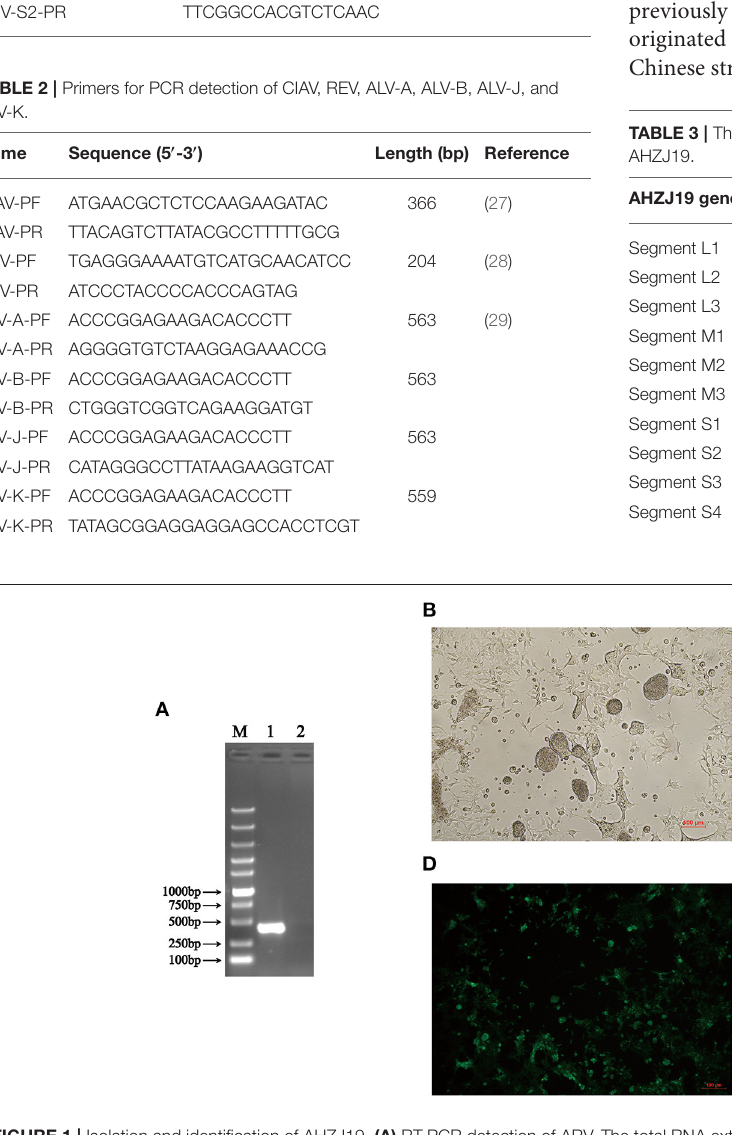
FIGURE 1 | Isolation and identification of AHZJ19. (A) RT-PCR detection of ARV. The total RNA extracted from the liver tissue samples was tested by RT-PCR using primers specific to ARV. Lane M was Super DNA Marker; Lane 1 was the liver tissue of chickens from that farm; Lane 2 was negative control. (B,C) The CPE in LMH cells at 24 hpi after inoculation with supernatants of the RT-PCR-positive liver tissue sample. (B) The supernatants of the RT-PCR-positive liver tissue sample were inoculated into LMH cells and the cells showed the typical characteristic syncytial lesions at 24 hpi. (C) The negative LMH cells were considered as control. (D,E) IFA for detecting antibodies against ARV in chicken serum from chicks inoculated with AHZJ19. The chicken serum collected and prepared at 3 wpi was used for detected the LMH cells by IFA. (D) LMH cells infected with AHZJ19 at 24 hpi. (E) Negative LMH cells was considered as control.